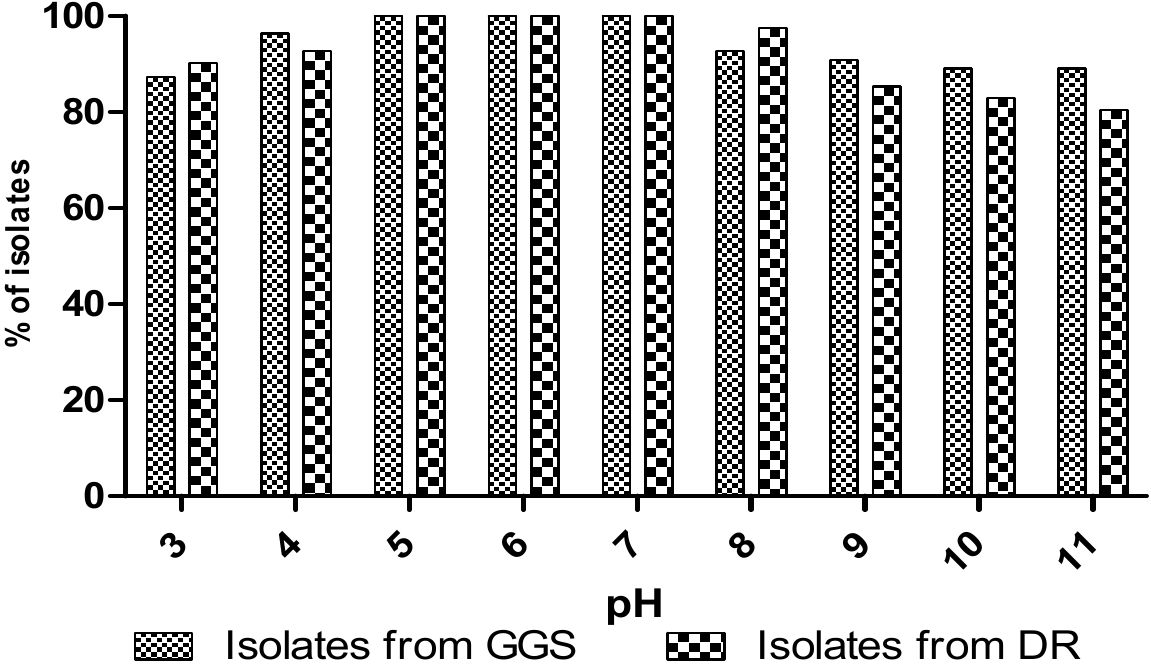
Figure 6. Effect of pH on growth of yeast isolates.